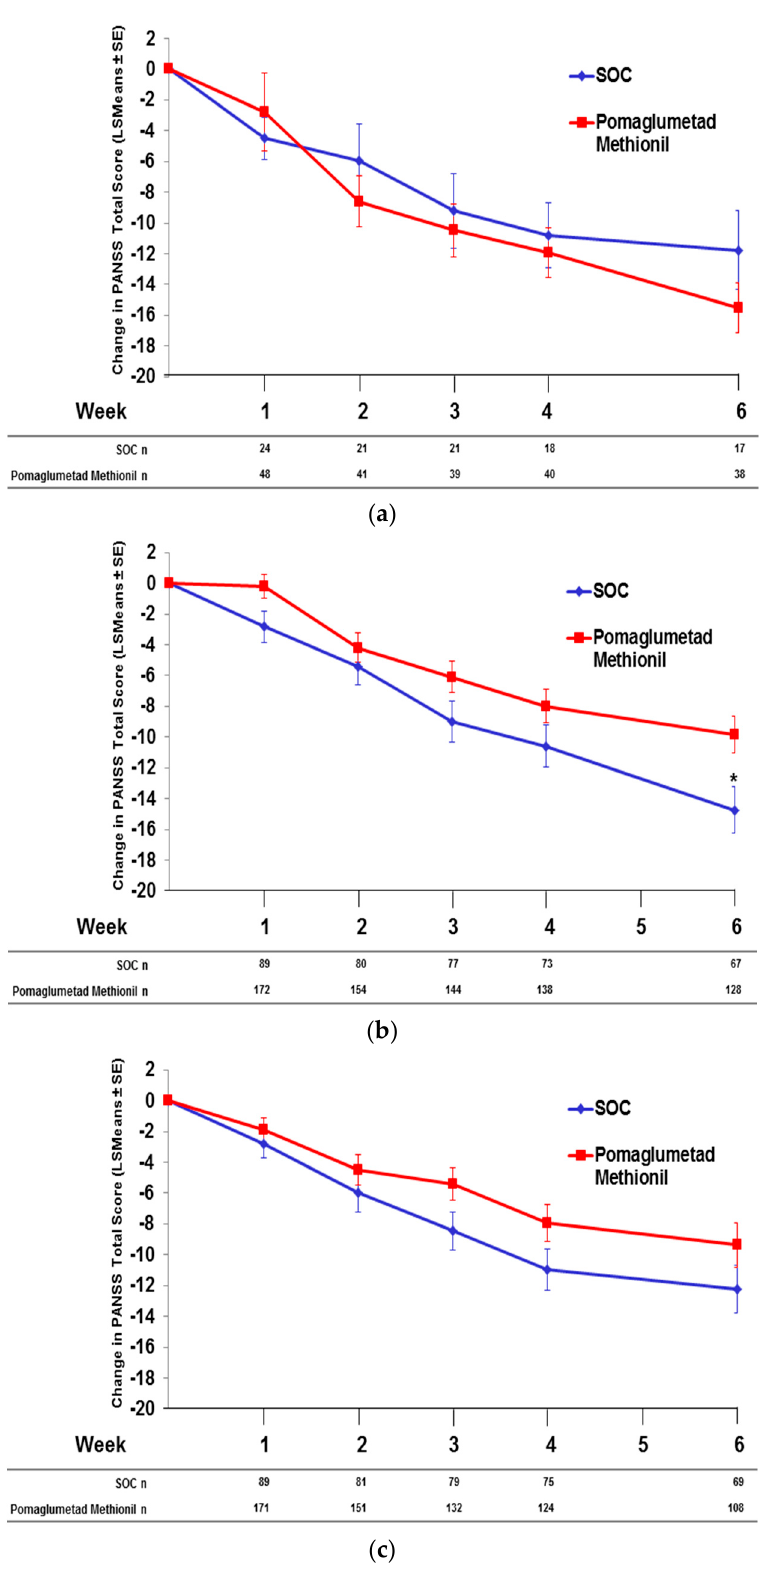
Figure 8. Integrated analysis; change in PANSS total score by HTR2A SNP rs7330461 genotype in Caucasian patients treated with pomaglumetad methionil versus standard of care; data from Studies 2, 3 and 4. ( a ) T/T homozygous patients. ( b ) A/T heterozygous patients. ( c ) A/A homozygous patients. Abbreviations: HTR2A = serotonin 2A receptor ( HTR2A ) gene; LSMeans = least squares means; n = number of patients with PANSS measures; PANSS = Positive and Negative Syndrome Scale; SE = standard error; SOC = standard of care; SNP = single nucleoside polymorphism.